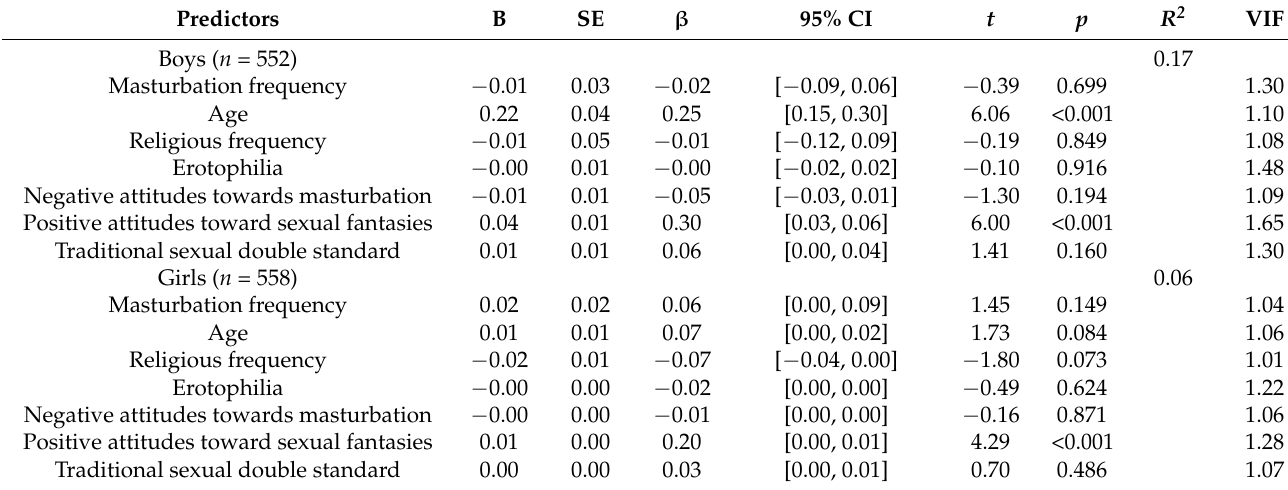
Table 4. Multiple regression models for sexual relationships frequency in boys and